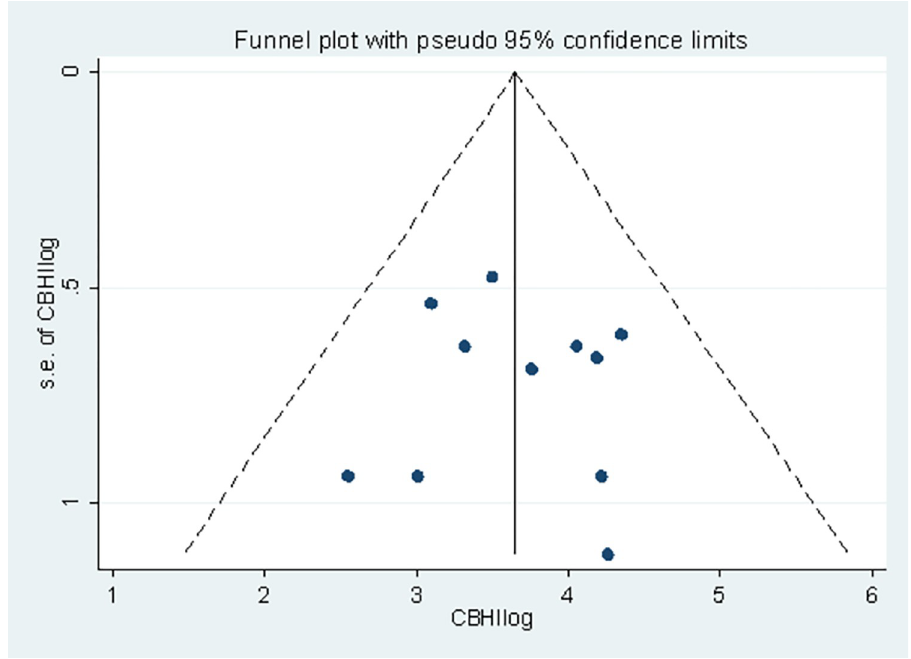
Fig 5. Funnel plot displaying publication bias of studies reporting the level of CBHI enrolment in Ethiopia, 2017– 2022.